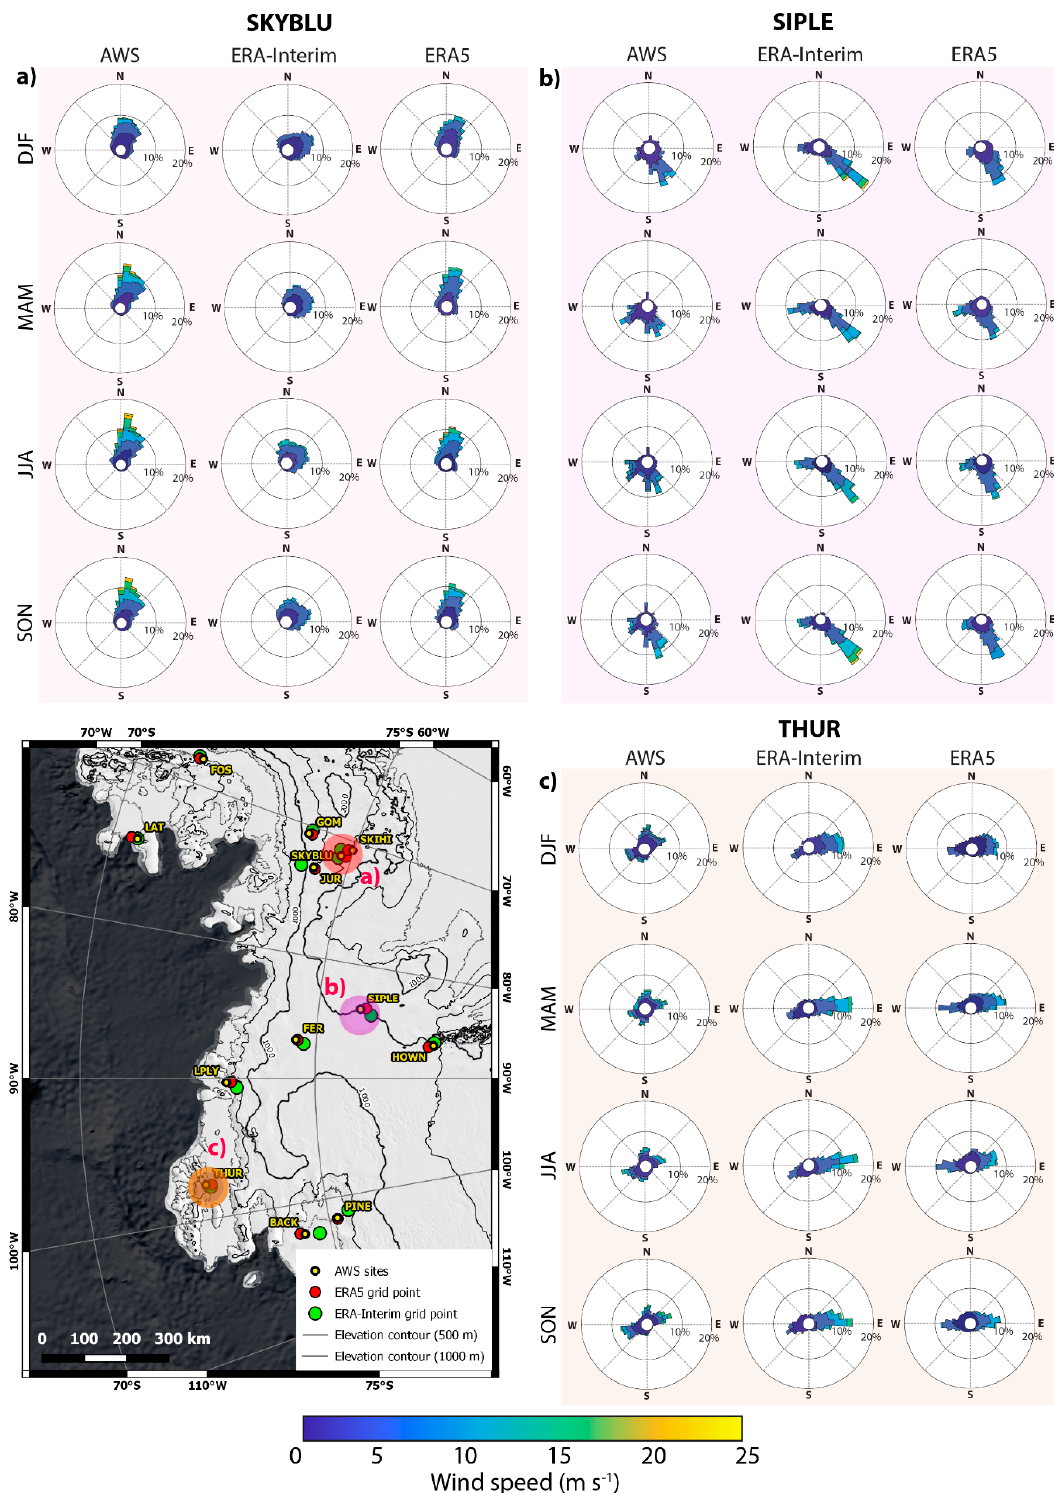
Figure 2. Seasonal wind rose plots on three AWS sites and their location within the study region. ( a ) Seasonal wind rose plots of SKYBLU AWS (2000–2017). ( b ) Seasonal wind rose plots of SIPLE AWS (1982–1992). ( c ) Seasonal wind rose plots of THUR AWS (2011–2017).